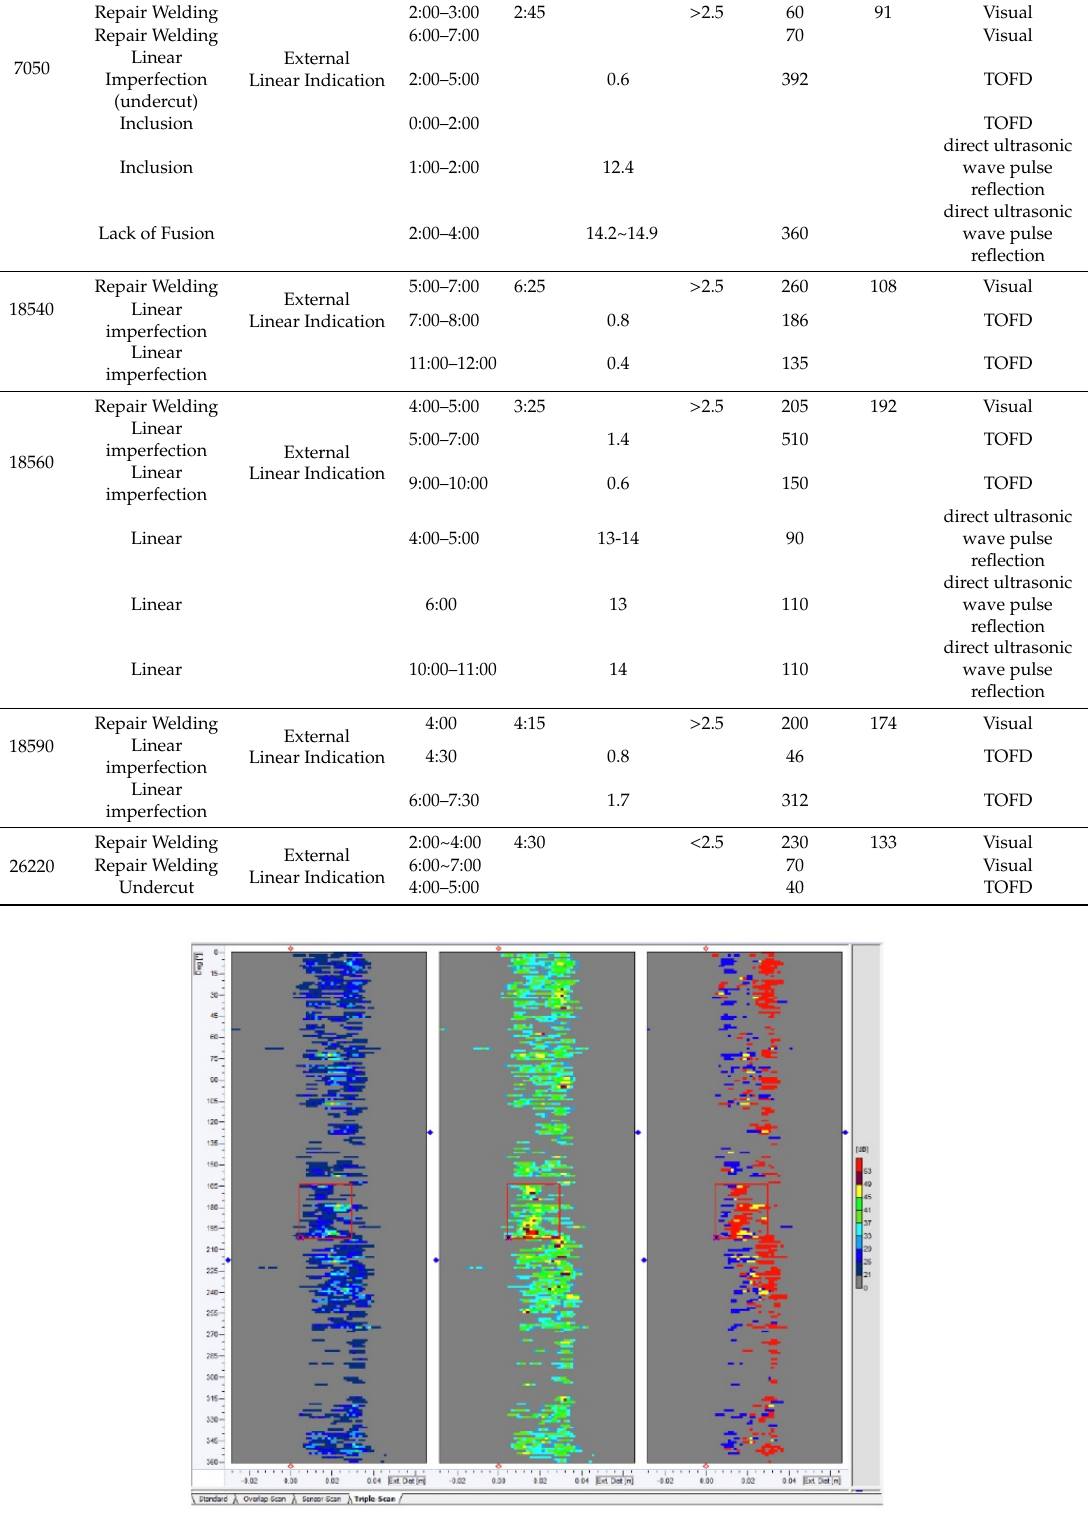
Figure 10. Signal of GW 18540.